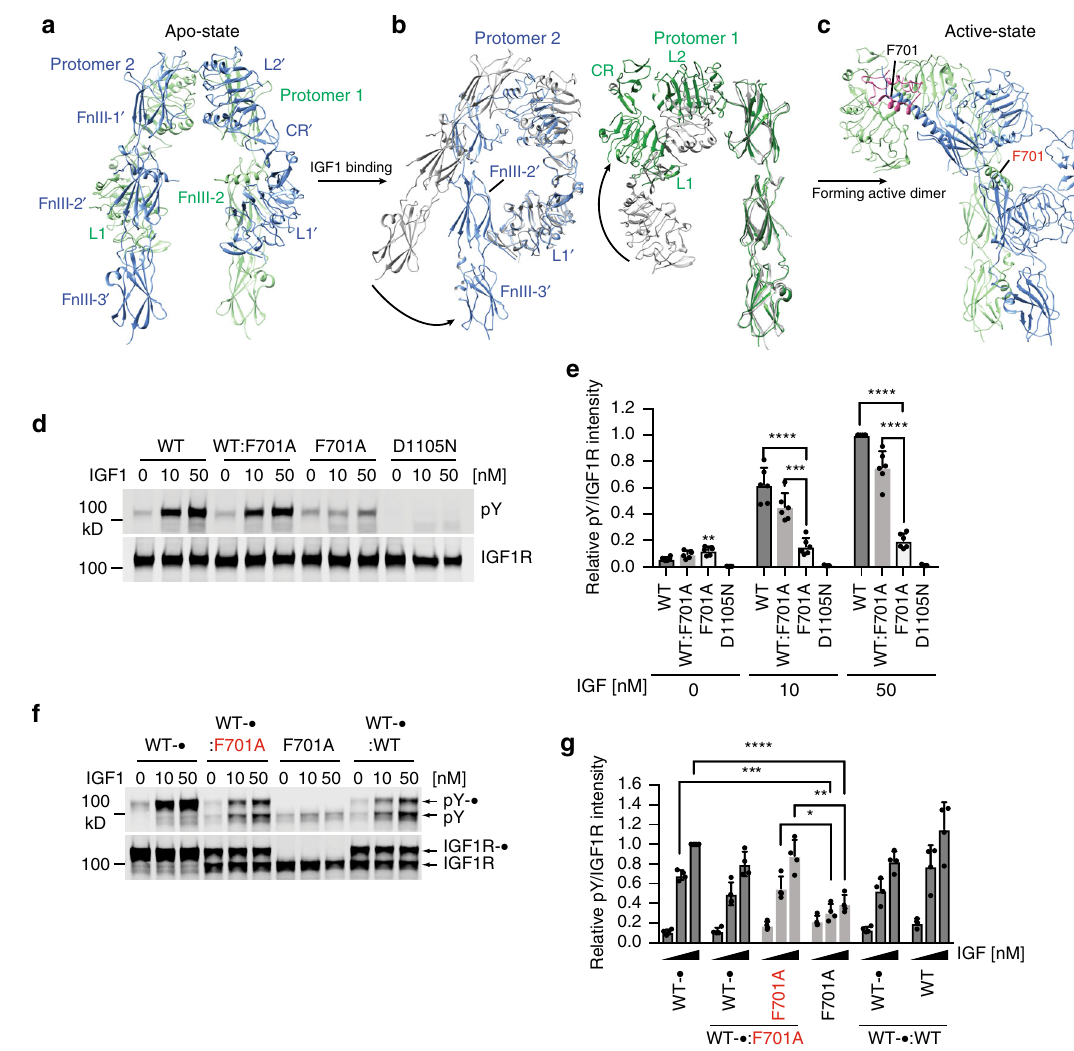
Fig. 2 Conformational change of each IGF1R protomer upon IGF1 binding. a Overall view of apo-IGF1R dimer. b Superposition between apo IGF1R protomer (gray) and the two different IGF1R protomers in the active state (blue or green) separately, revealing two different types of conformational changes upon IGF1 binding (indicated by the arrows). c Overall view of active-IGF1R dimer. d IGF1-induced IGF1R autophosphorylation in 239FT cells expressing wild-type (WT) alone, WT:F701A or F701A alone. Kinase dead mutant (D1105N) was used as a negative control. e Quanti fi cation of the western blot data shown in d (Mean ± SD). Each experiment was repeated six times. Signi fi cance calculated using two-tailed students t -test; between WT and mutant; ** p < 0.01 *** p < 0.001, and **** p < 0.0001. f IGF1-induced IGF1R autophosphorylation in 293FT cells expressing Myc-tagged WT (WT- (cid:129) ) alone, Myc-tagged WT: untagged F701A (WT- (cid:129) :F701A), untagged F701A alone or Myc-tagged WT: untagged WT (WT- (cid:129) :WT). g Quanti fi cation of the western blot data shown in f (Mean ± SD). Each experiment was repeated three times. Signi fi cance calculated using two-tailed students t -test; * p < 0.05, ** p < 0.01, *** p < 0.001, and **** p < 0.0001. Source data are provided as a Source Data fi